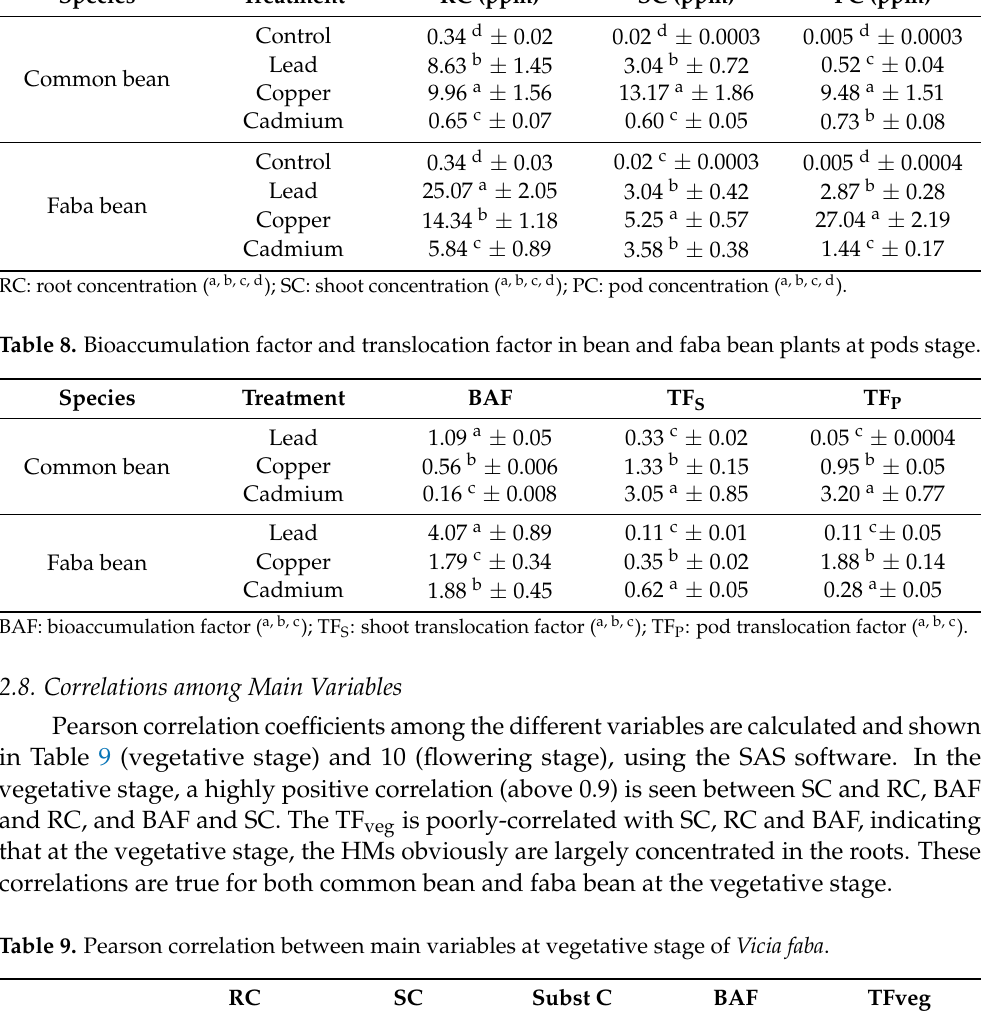
Table 7. The HM concentrations in roots, shoots and pods at the pods-stage. Species